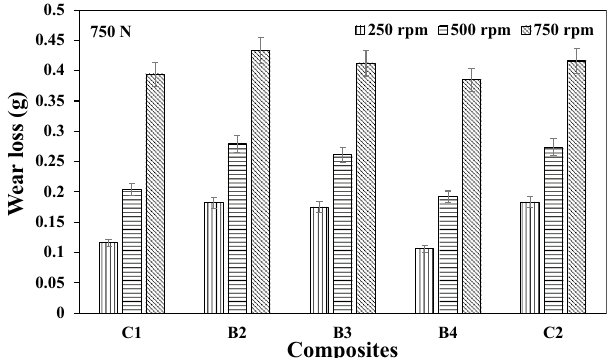
Figure 3. Wear loss at load 750 N under different speed for the composites.